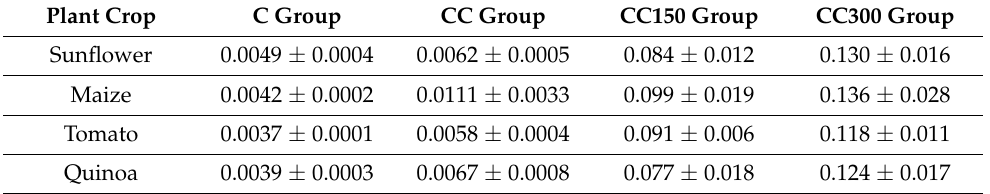
Table 2. Salt concentration in soil (M) estimated by the EC compared with the standard curve.